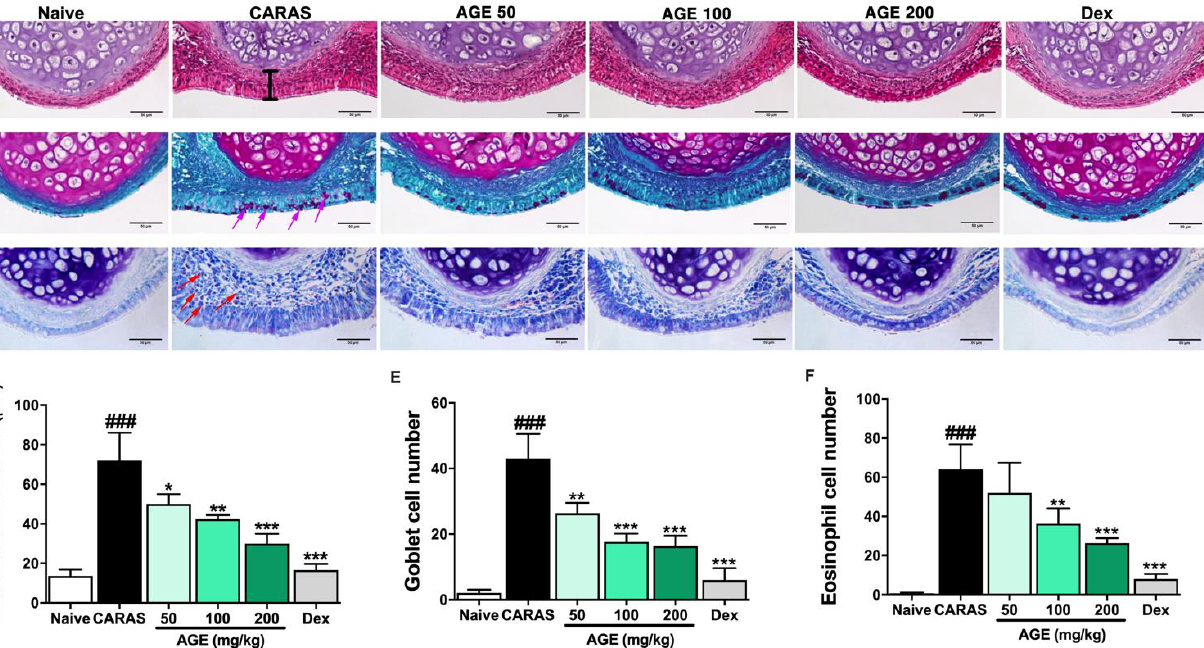
Figure 3. AGE ameliorated nasal mucosa swelling and goblet cell hyperplasia in CARAS mice. ( A ) H&E staining, ( B ) PAS staining. ( C ) Giemsa staining. ( D ) Submucosal thickness. ( E ) Goblet cell number in the nasal epithelial. ( F ) Eosinophil number infiltrated in the nasal tissue. All pictures were at a magnification of 400×. By H&E staining, abnormal morphology of nasal tissue was observed in the CARAS group: the sub-epithelium was significantly infiltrated by inflammatory cells, the epithelium was swelling. However, it was considerably reverted in the treated group with AGE 200 mg/kg and Dex 2.5 mg/kg. By PAS staining, the goblet cells appeared with a violet color. Goblet cell hyperplasia in the epithelial layer of the CARAS mice was considerably alleviated by AGE 50 and 100 mg/kg. The infiltration of eosinophils was detected by Giemsa staining. The majored infiltration of eosinophil in the CARAS mice was reduced by the treatment with AGE. The purple head arrows indicated goblet cells; the redhead arrows indicated eosinophils. All results are shown as the mean ± SD (n=6 per group). # Compared to naive, * compared to CARAS. ### , *** p < 0.001; ** p <0.01; * p <0.05. CARAS = combined allergic rhinitis and asthma syndrome; AGE = Artemisia gmelinii extracts; Dex = dexamethasone; H&E = hematoxylin and eosin; PAS = periodic acid – Schiff. Scale bar = 50 µm.